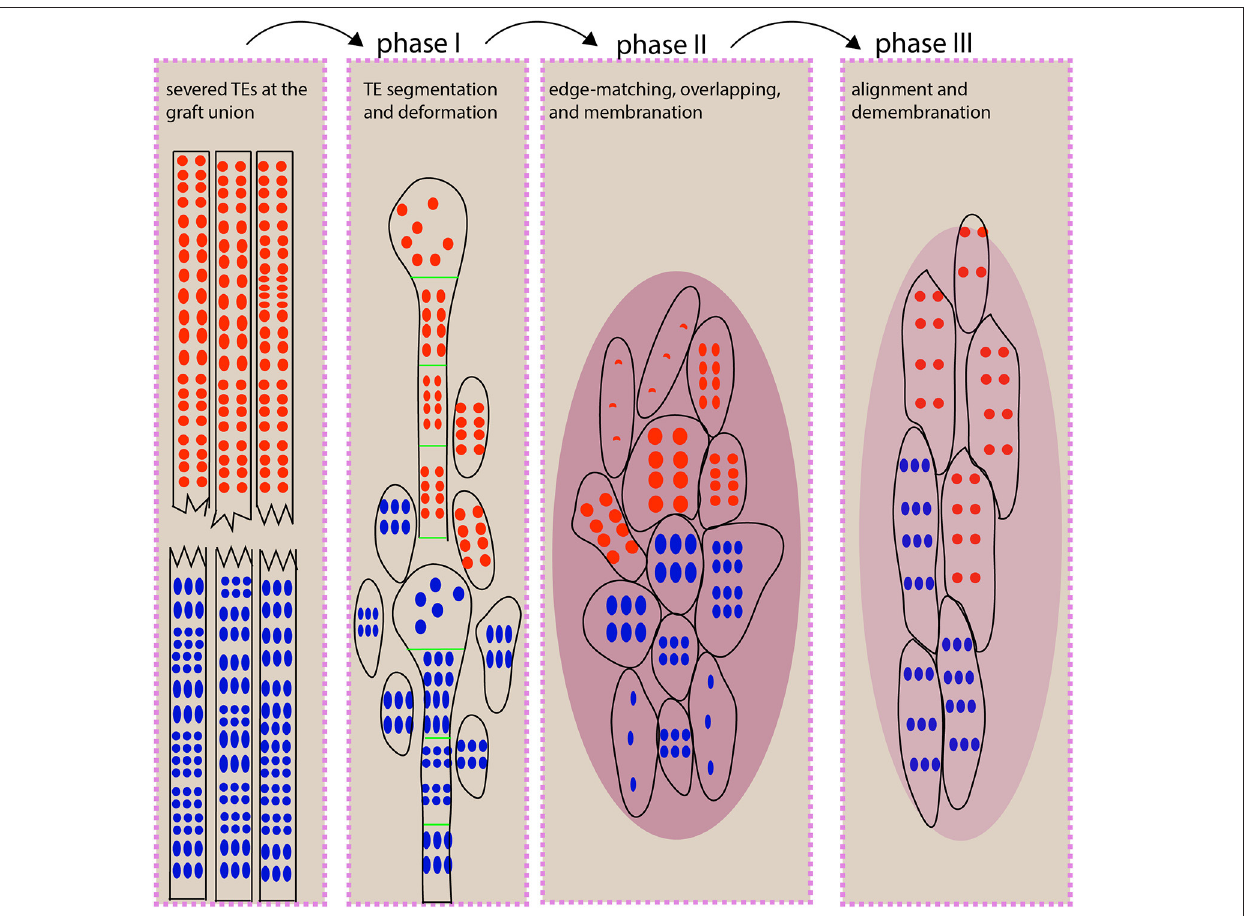
FIGURE 7 | An illustration for TE behavior during scion-rootstock interaction. At the graft union, xylem connection depends on small, short TE behaviors, and this process can be distinguished into three phases. During phase I, the vascular strands at the grafting interface undergo segmentation and deformation (e.g., expansion of a TE diameter) to fill the gap between scion and rootstock. We propose that the segmented TEs may serve as timely “xylem fillers” that could provide a critical stopgap ahead of the full repair. In addition, the TE expansion leads to the increased surface area and volume, thereby increasing the likelihood of contacts. During phase II, the short TEs match with each other in a homogeneous way. The graft union is covered with membrane-like cellular deposits. Some newly differentiated TEs are beginning to form. During phase III, TEs are aligned vertically via fusion or overlapping to form a continuous network. The cellular deposits are withdrawn. The red and blue dots represent pits from scion and rootstock, respectively. The oval with few dots represents the newly differentiated TEs. The dark magenta oval represents cellular deposits. The light magenta oval represents reduced